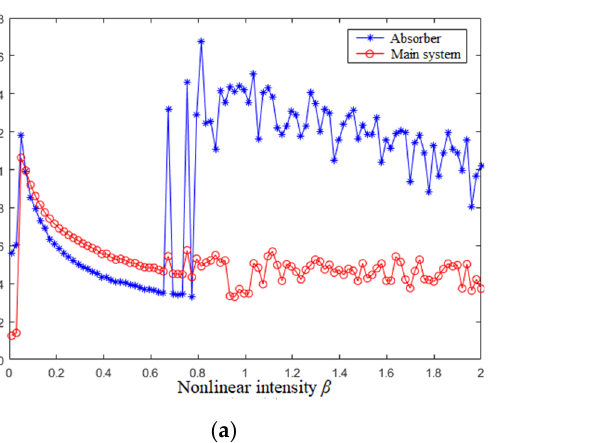
Figure 16. Response amplitude and phase diagram of two vibrators in the case of off-resonance ω = 1.6. ( a ) Response amplitude; ( b ) Phase diagram ( β = 0.9).